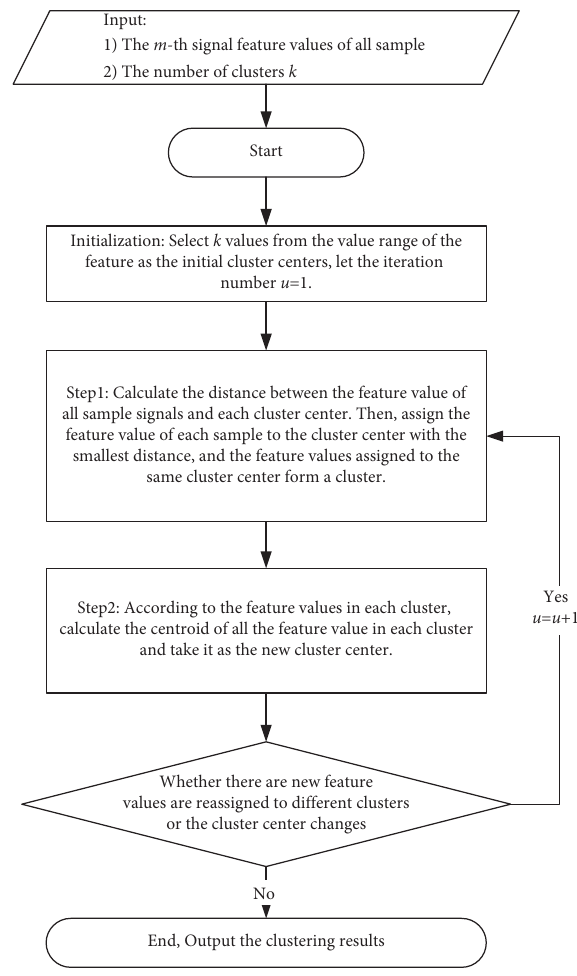
Figure 3: Algorithm flowcharts of feature state coding based on K -means